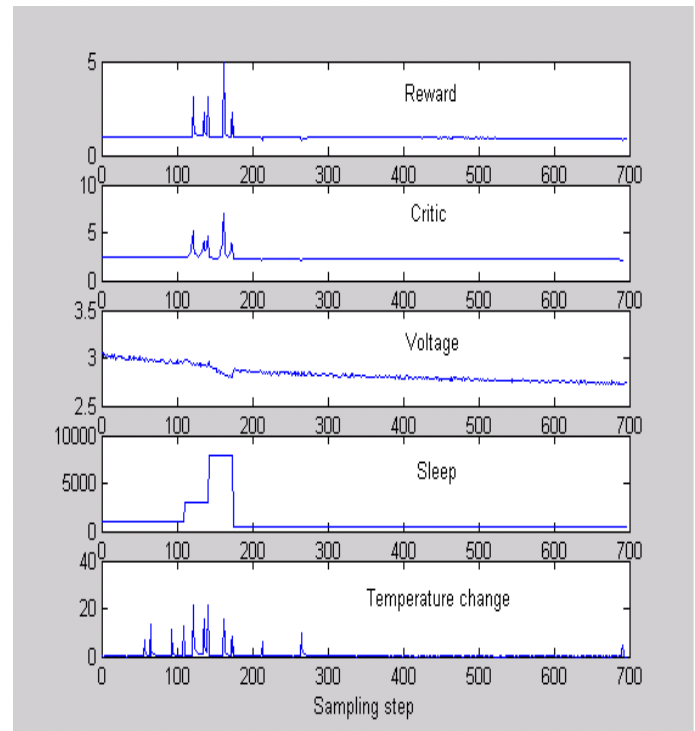
Figure 5. Evaluations of reward and critic.